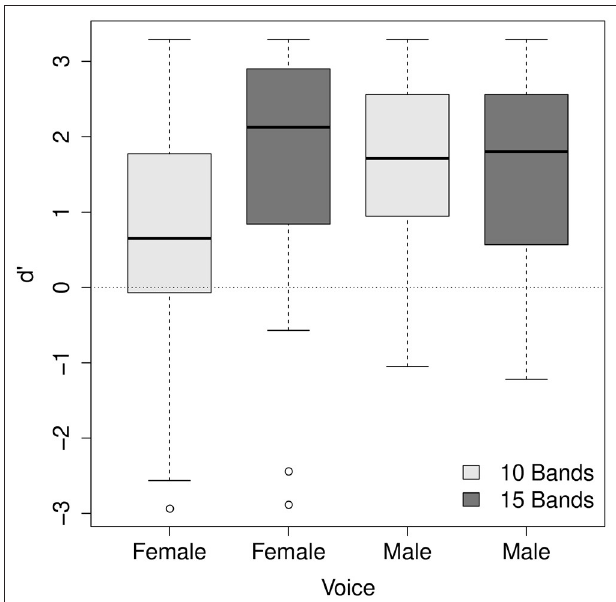
FIGURE 6 | The interaction between the number of frequency bands and